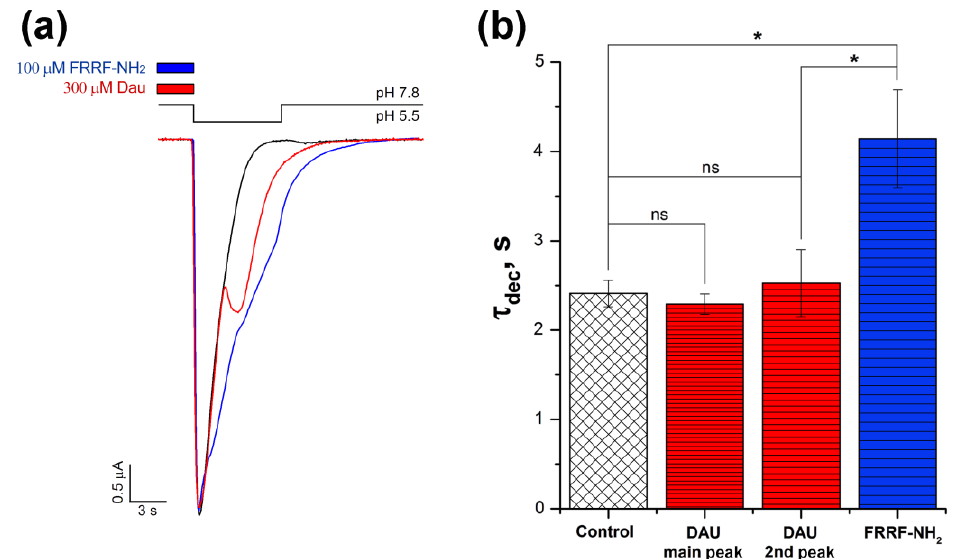
Figure 3. Comparison of the e ff ects that DAU and the RF-amide peptide have on ASIC1a current. ( a ) Representative traces of pH 5.5-evoked currents of ASIC1a alone (black trace) and of ASIC1a with a 15 s pre-incubation of 300 µ M DAU (red trace) or 100 µ M FRRF-NH2 peptide (blue trace). ( b ) E ff ects of 300 µ M DAU and 100 µ M FRRF-NH2 peptide on the time of exponential decay ( τ dec ) for the main peak (both control and with the peptide) and for the second (DAU) component of the current (DAU). Time τ dec was calculated as the interval between the maximum of the current amplitude and the point having 1 / e times reduced amplitude to this maximum. The significance of data was proved by statistical analysis of variance followed by a Tukey’s test ANOVA. Results are presented as mean ± SEM (n = 5–12); ns—non significantly di ff erence; * P < 0.05.